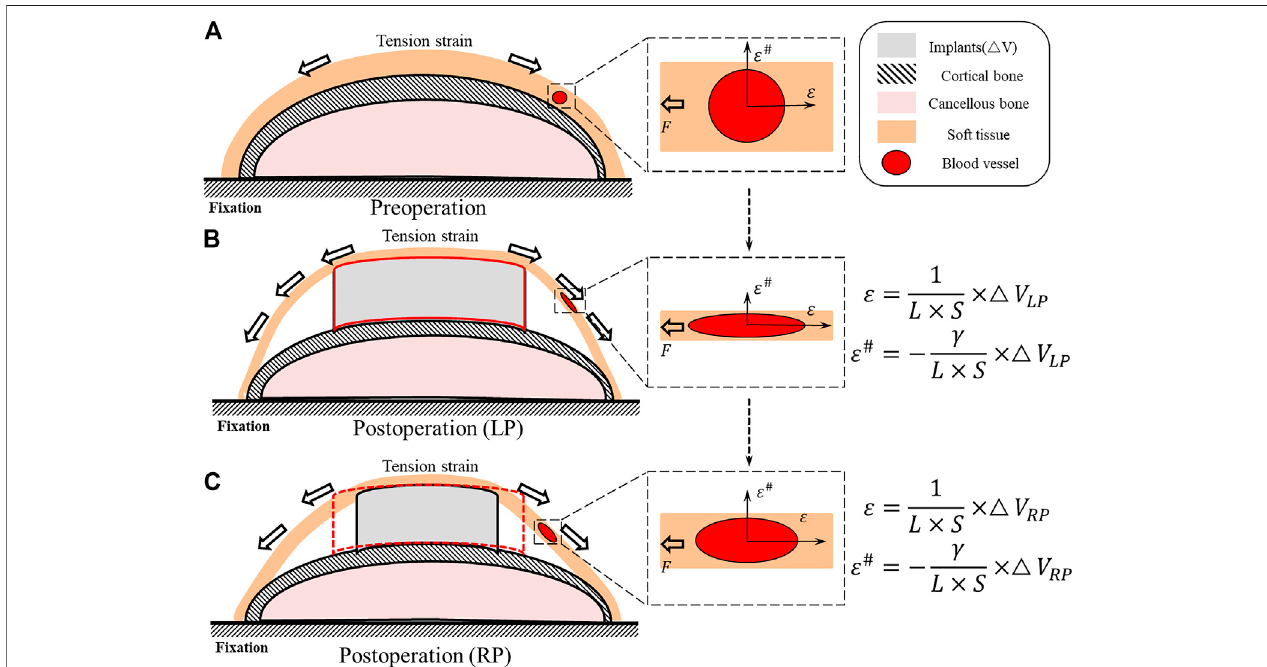
FIGURE2| Schematicdiagramoftheinternalimplantationofthedistaltibiafractureimplant. (A) Therelativepositionandmorphologyofthetibiaandthesofttissue of the skin and the blood vessels passing through it under physiological conditions. (B) The strain increases after LP implantation and causes the strain of the strain direction ε to increase and the strain in the vertical direction ε # to increase. This leads the soft tissue and blood vessels to stretch with the affected blood the supply. (C) Afterimplantation,withsmaller Δ V ,thestrainofthestraindirection ε isreduced,andthestrainintheverticaldirection ε # isreduced,andthedeformationofthesoft tissue and blood vessels is